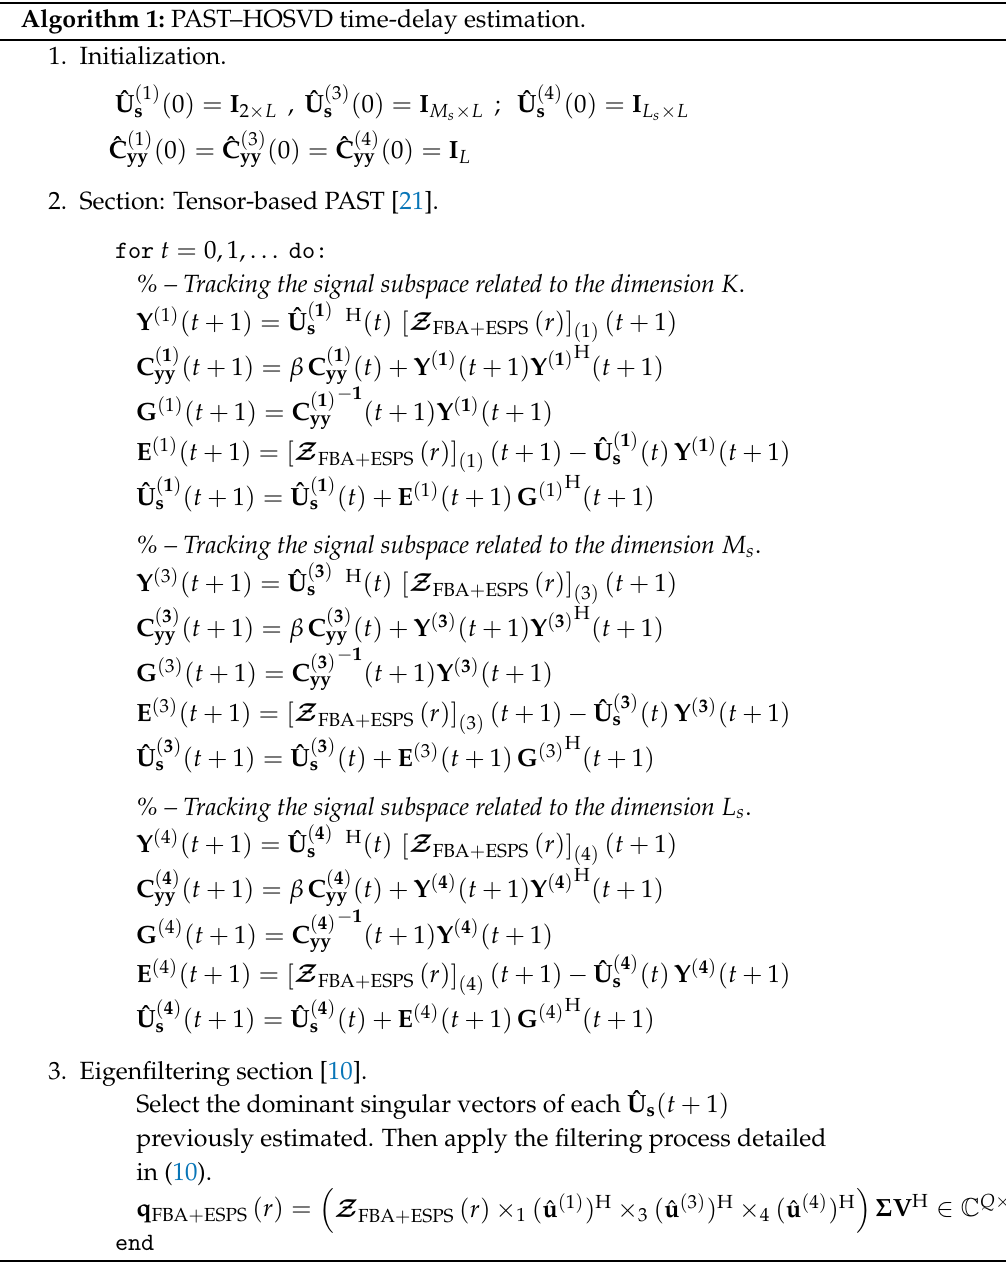
Algorithm 1: PAST–HOSVD time-delay